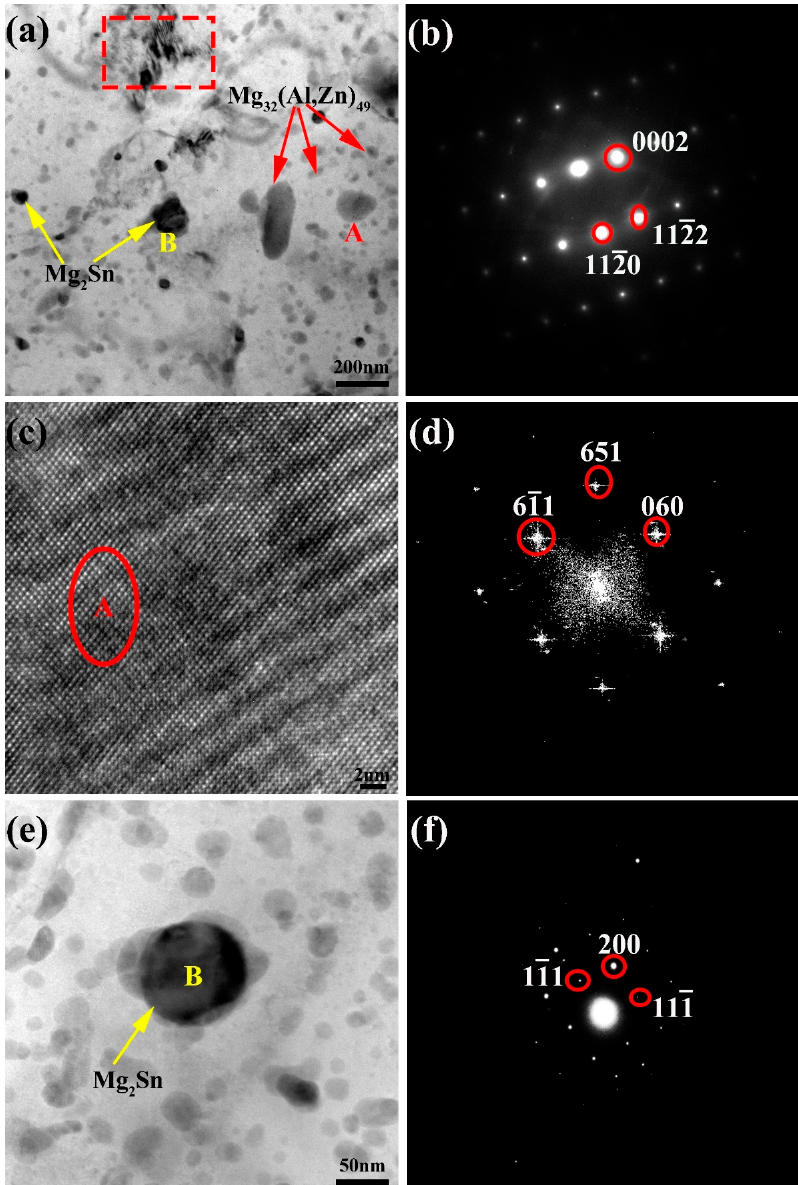
Figure 4. ( a ) Transmission electron microscopy (TEM) images of extruded ZAT541 alloy. ( b ) The selected area electron diffraction (SAED) of matrix. ( c ) High-resolution episcopic